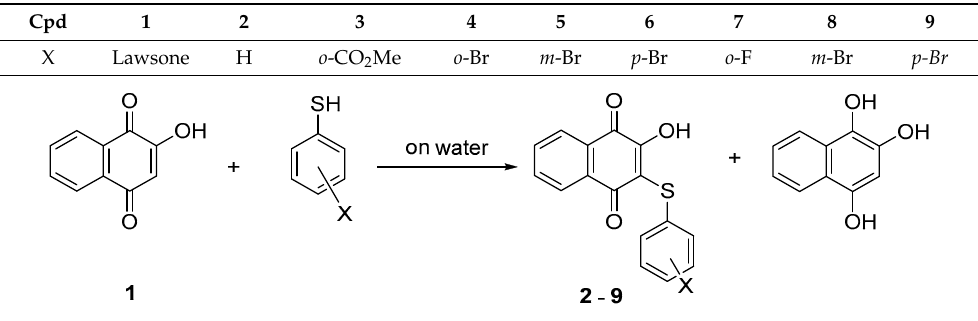
Table 1. Compounds studied in this work [26].